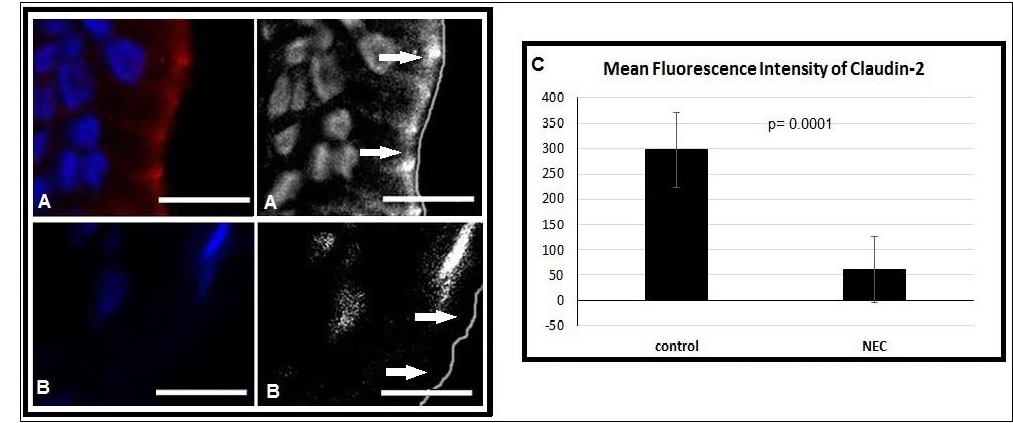
Figure 1: A) Claudin-2 is identified in the intestinal epithelial cells of a control infant that does not have NEC, indicated by the red stain and the white arrows. B) Claudin-2 is missing from the intestinal epithelial cells of an infant that does have NEC, indicated by the absence of red staining and the white arrows. C) MFI reveals a significant decrease in the amount of claudin- 2 in the intestinal epithelial cells of the NEC infant versus the control infant